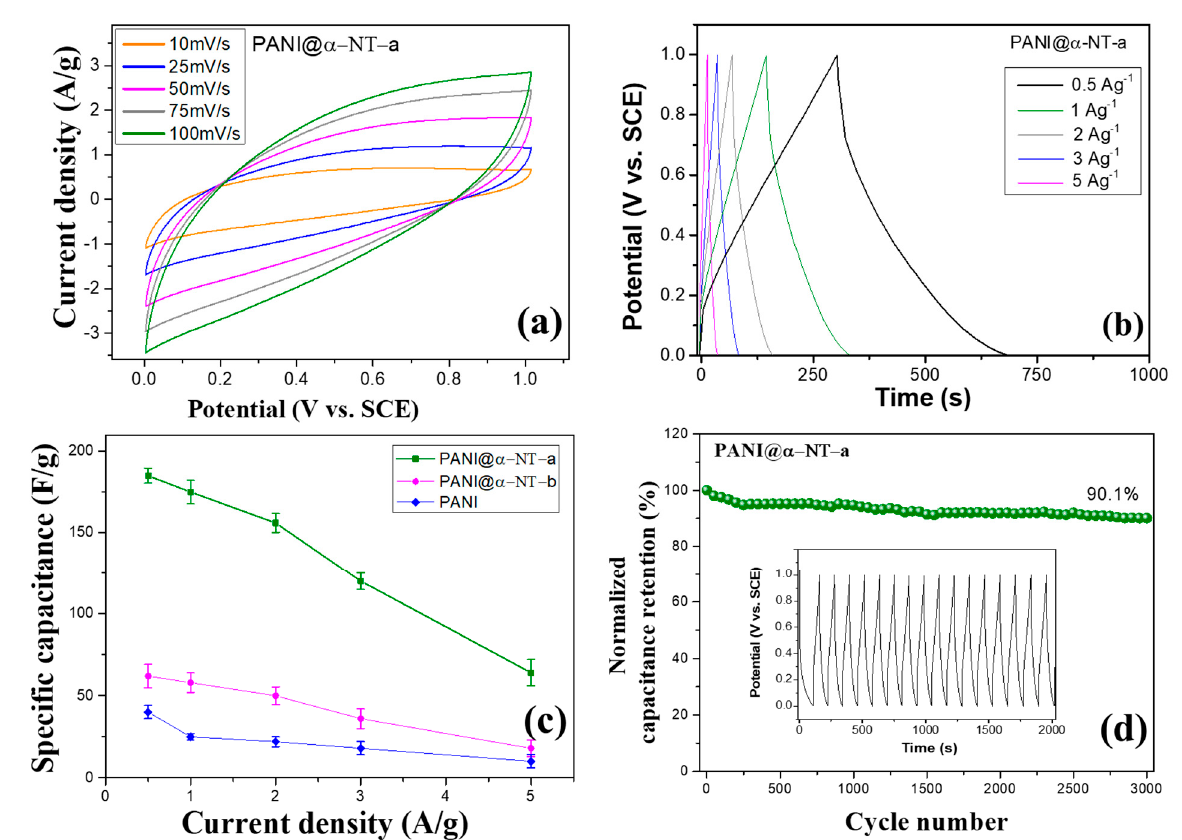
Figure 7. ( a ) Cyclic voltammetry (CV) curves for PANI@ α -NT-a at different scan rates. ( b ) Charge–discharge curves for PANI@ α -NT-a at different current densities. ( c ) The specific capacitance of PANI@ α -NT-a, PANI@ α -NT-b, and PANI electrodes at different current densities. ( d ) Cycling performance of PANI@ α -NT-a electrode for 3000 cycles by GCD (the inset is GCD curves in the first 16 cycles).